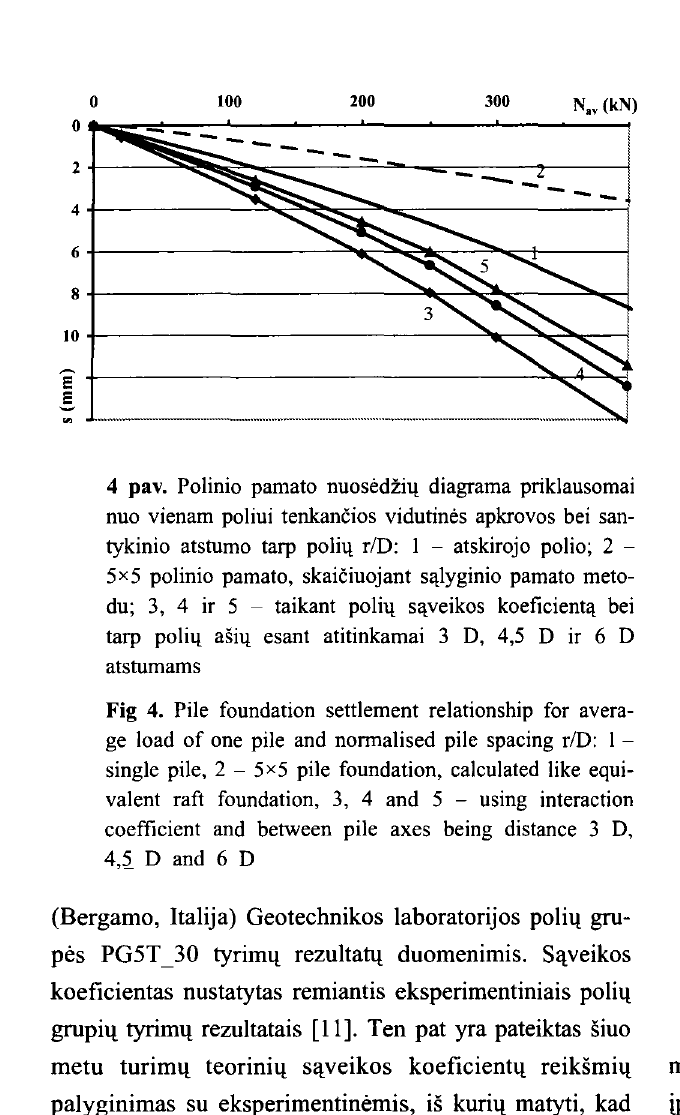
Fig 5. Loads distribution in special piles of 5x5 pile foundation relationship for average load of one pile and normalised pile spacing r/D. l. 2. 3 - comer, border and central pile then between pile axes being distance 3 D; 4, 5, 6 - comer, border and central pile, then bet ween pile axes being distance 4.5 D: 7. 8, 9 - comer, border and central pile, then between pile axes being distance 6 D Be polinio pamato nuosedziq, reikia atkreipti de mesi ir i ir<tZll pasiskirstym<t poliuose (5 pav.). Esant iPrastiniam poliq isdestymui (r!D=3), pradiniu apkrovi piniame polyje ji yra net 19,5% didesne, o centriniame 20,0%